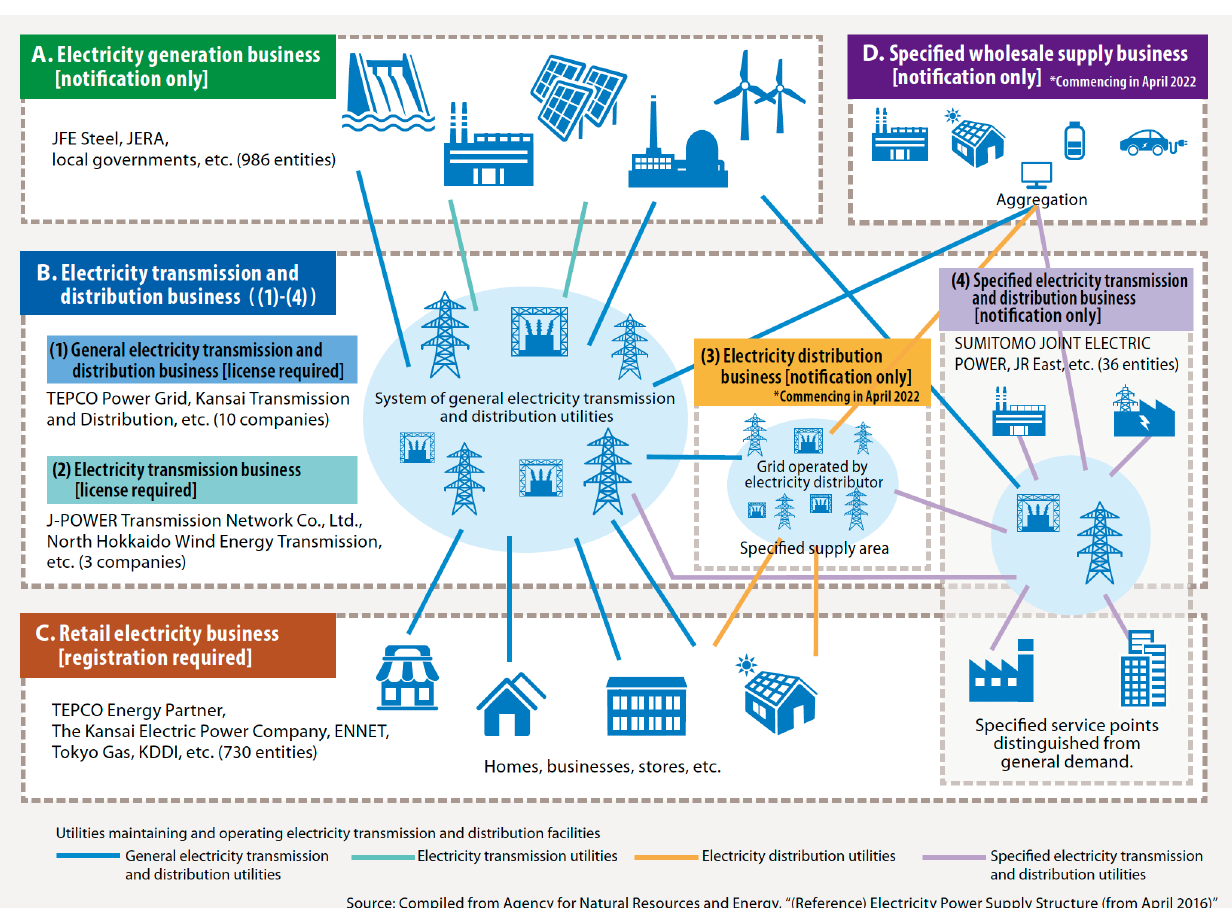
Figure 2. General organization of the Japanese electricity market